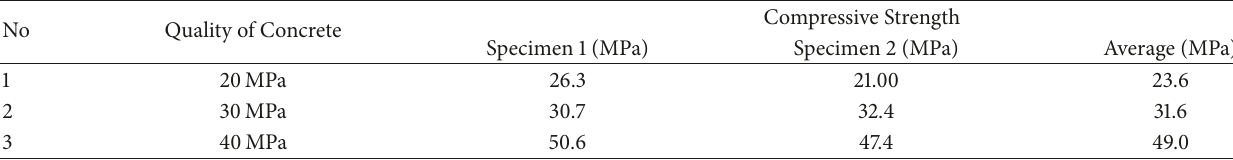
Table 3: Average compressive strength during preliminary test.